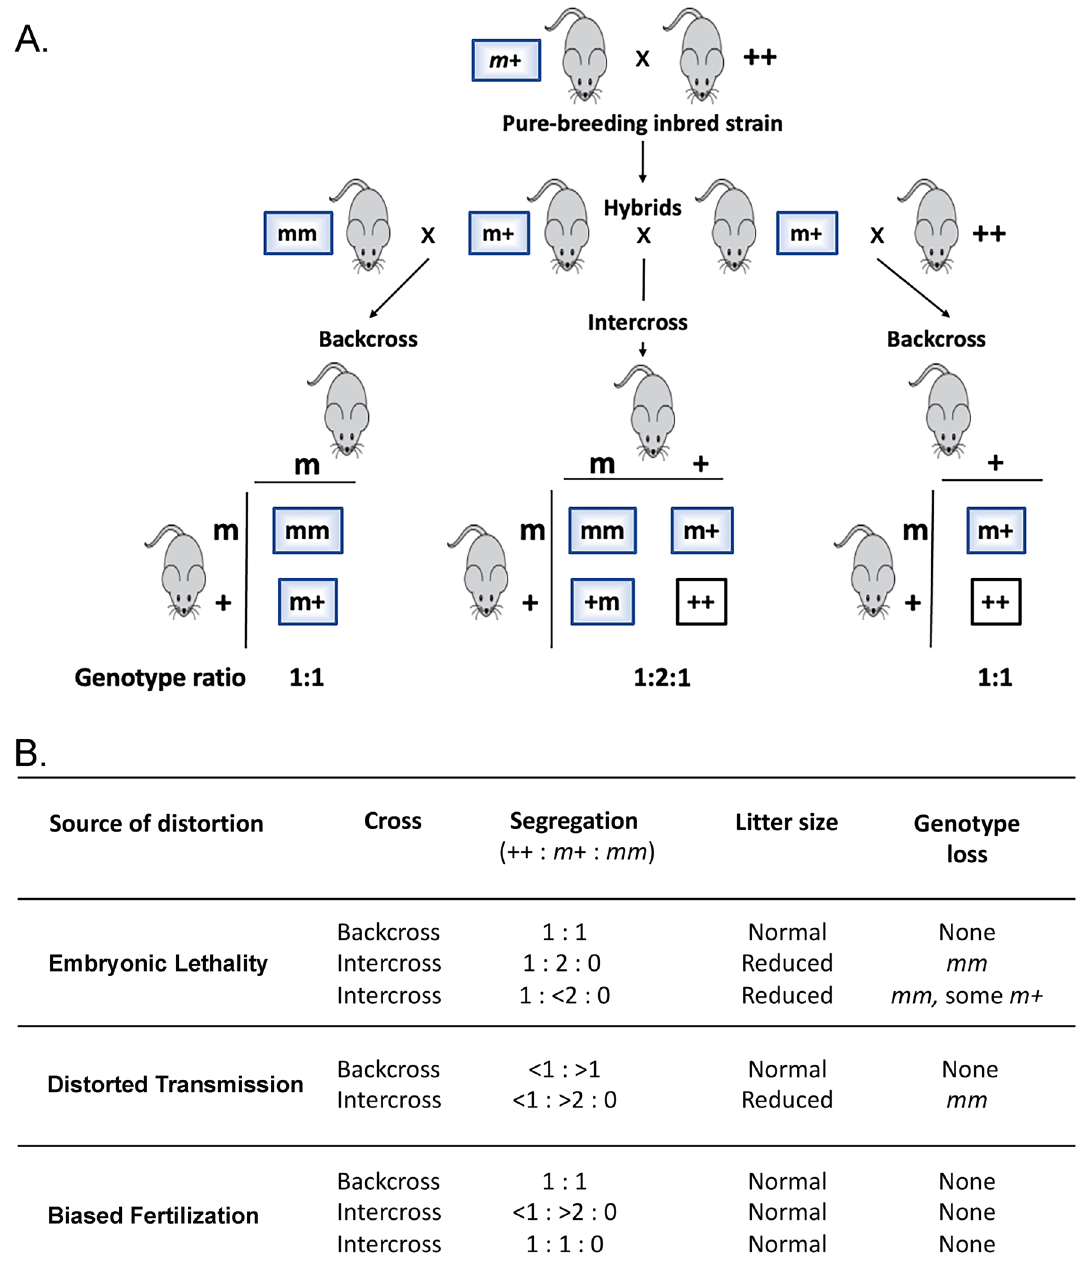
Figure 1. Mendelian segregation and deviations from expectations. ( A ) Mendelian segregation. ‘ m ’ and ‘+’ designate the mutant and wild-type allele, respectively. Intercrosses between inbred strains make F1 hybrids. Hybrids are then crossed to either parental strain for backcrosses or inter se for intercrosses. Genotype ratios are based on Mendelian expectations. ( B ) Distinct segregation ratios, litter size, and genotype loss depending on the basis for non-Mendelian segregation 66 . With embryonic lethality, mutant alleles that compromise viability of mm homozygotes can also result in loss of some m + heterozygotes (partial dominance), which can further reduce litter size. Intercrosses can show an excess (< 1: > 2) or a deficiency (1:1) of m + relative to